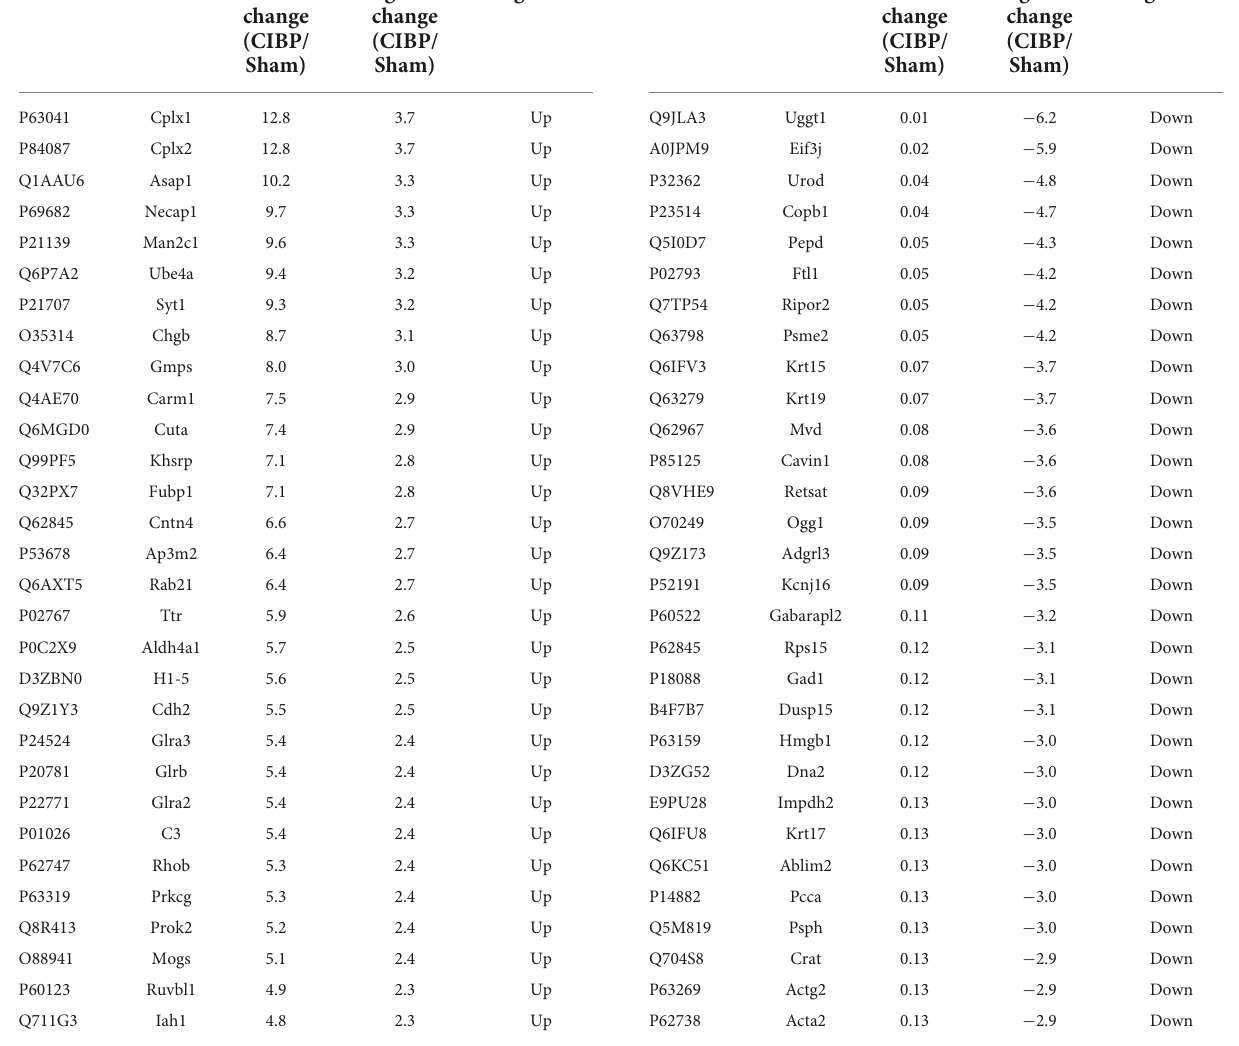
Fold change (CIBP/ Sham)